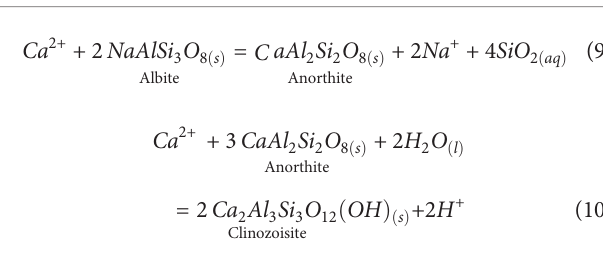
FIGURE 5 | Chondrite normalized REE pattern for endmember fl uids from East Scotia ridge (Dog ’ s Head and Iced Bun) compared with endmember fl uids from other mid-oceanic ridge systems and back-arc basins that show similar patterns. The data represented here is from Douville et al. (1999) (TAG and Lucky Strike), Cole et al. (2014) (Dog ’ s Head, Sepia), Craddock et al. (2010) (Fenway). The seawater (SW) values are taken from Cole et al.